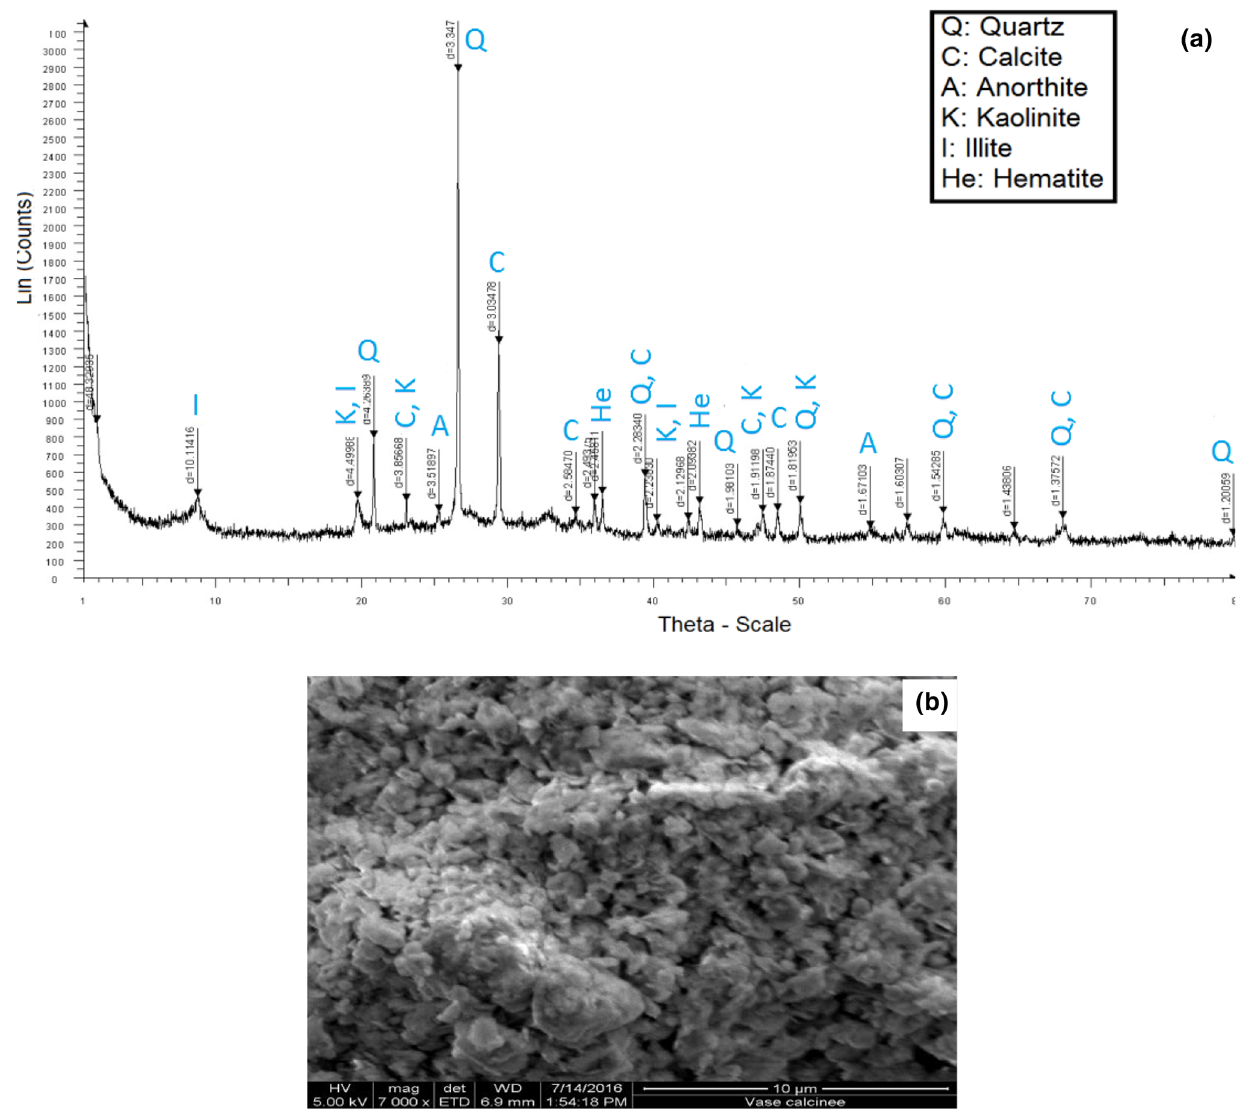
Fig. 4 a XRD analysis of calcinated mud and b EDS analysis of calcinated mud.